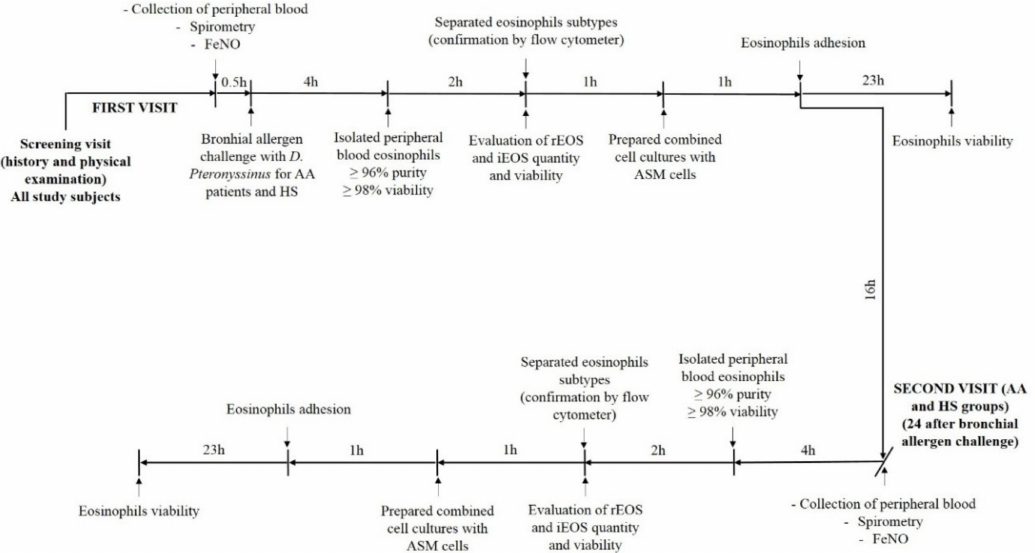
Figure 2. Experimental study design. AA—Allergic asthma; ASM—Airway smooth muscle; FeNO—Fractional exhaled nitric oxide; HS—Healthy subjects; iEOS—inflammatory eosinophils; rEOS—lung-resident